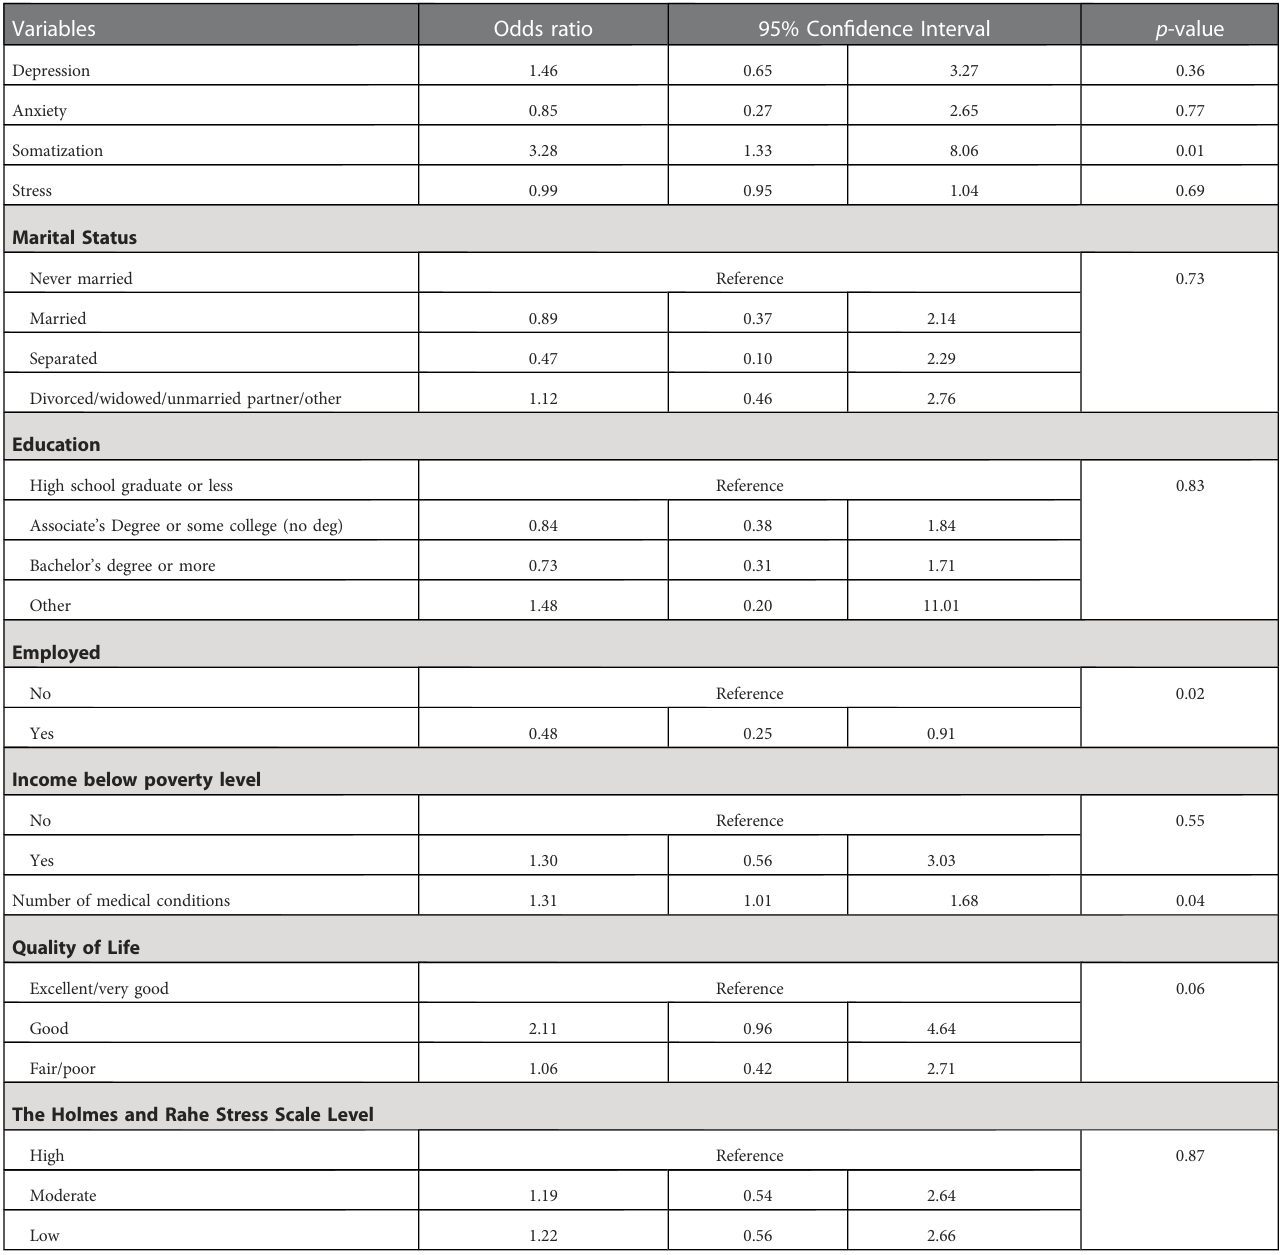
TABLE 2 Association between pain and psychosocial factors adjusted for potential